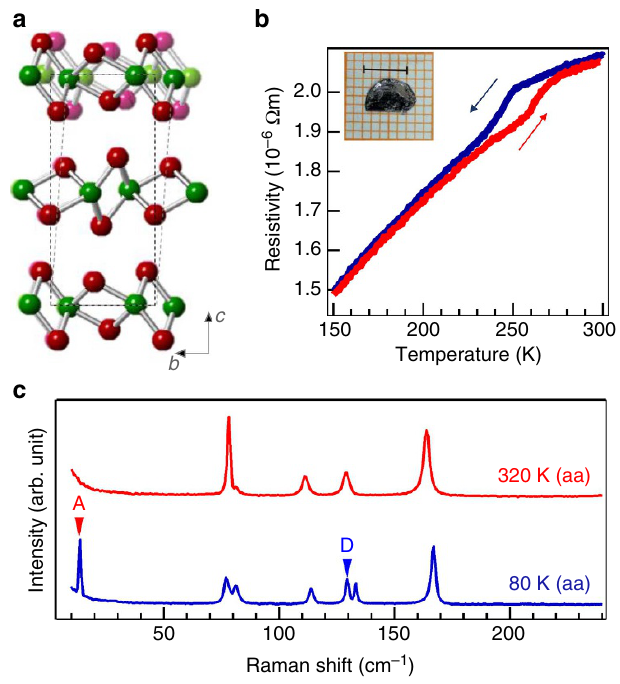
Figure 1 | Temperature-induced phase transition in MoTe 2 . ( a ) Crystal structures of 1 T 0 (shadow) and T d (solid) phases. ( b ) Resistivity measurement shows a temperature-induced phase transition. The inset shows a photograph of the high-quality single crystal; scale bar, 5mm. ( c ) Raman spectra at 320 and 80K. The letters inside the parenthesis indicate the polarization directions for incident and scattering lights. NATURE COMMUNICATIONS|7:13552|DOI: